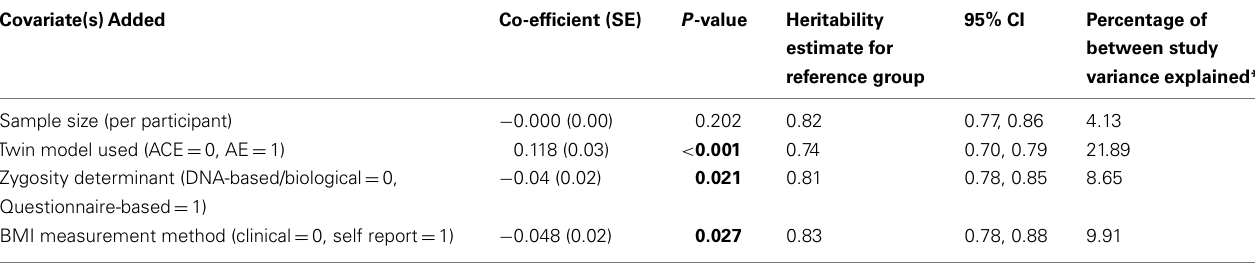
Table 3 | Results of meta-regression analyses to identify study-level methodological factors associated with reported BMI heritability estimates in twin